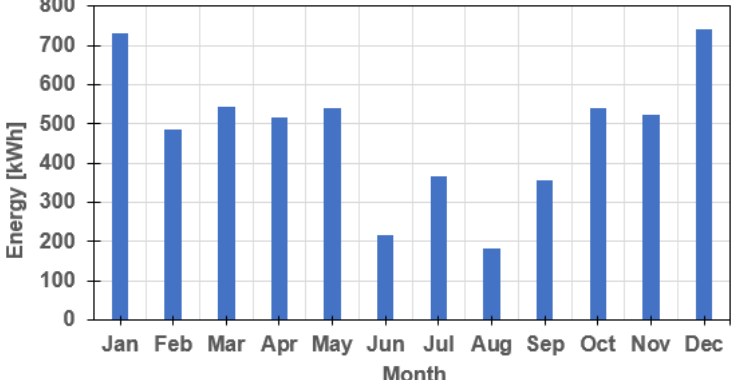
Figure 3. The monthly consumption of the selected Ger-3 in Figure 2.